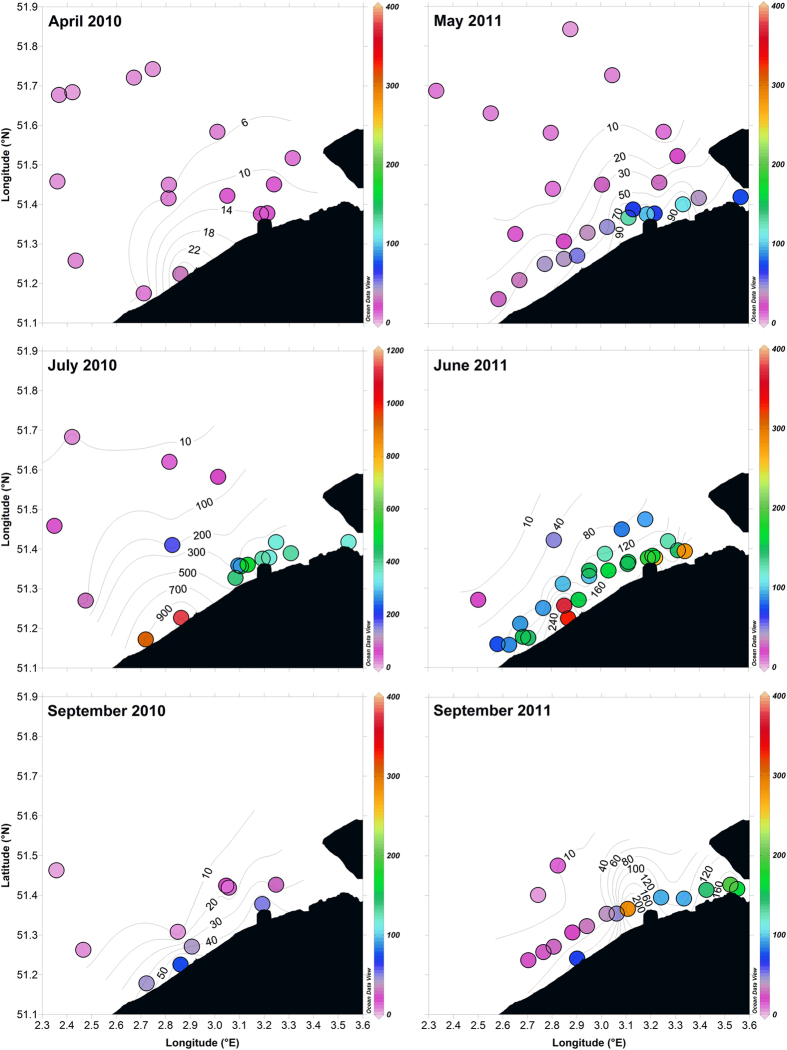
Hot-spot of dissolved CH4 concentration in the near-shore North Sea (up to ~300 times higher than in the open ocean).Concentration of dissolved CH4 (nmol L−1) in surface waters of the Belgian coastal zone (BCZ) in spring, summer and fall 2010 and 2011. Note the different color scale in July 2010 compared to the other cruises. Figure was produced by authors using Golden Software Surfer version 8.03 (http://www.goldensoftware.com/) and Ocean Data View version 4.6.3.1 (https://odv.awi.de/).